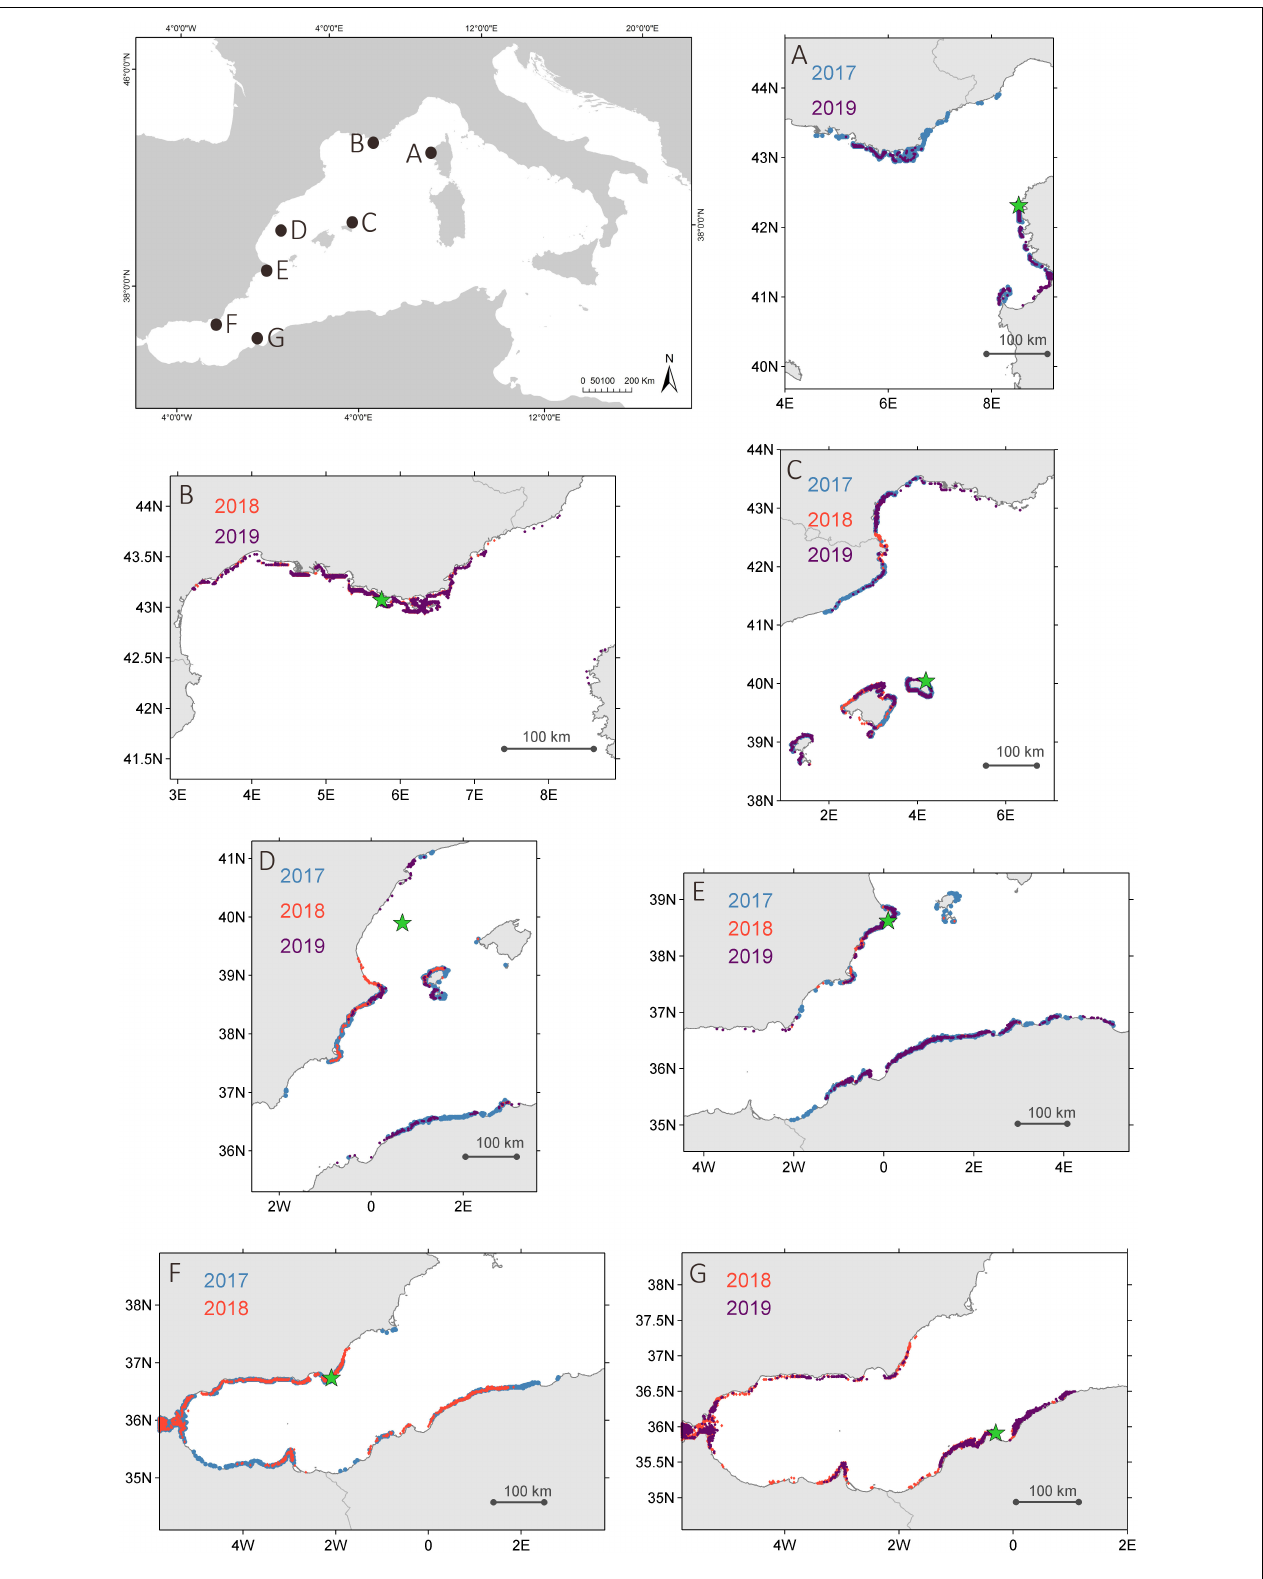
FIGURE 4 | Results of the Lagrangian trajectory model showing the potential origin of P. nobilis larvae for each site and year, (A) Scandola, (B) Embiez, (C) Son Saura, (D) Columbretes, (E) Calpe, (F) Cabo de Gata, (G) Arzew. Sites are represented on the maps by the green star.